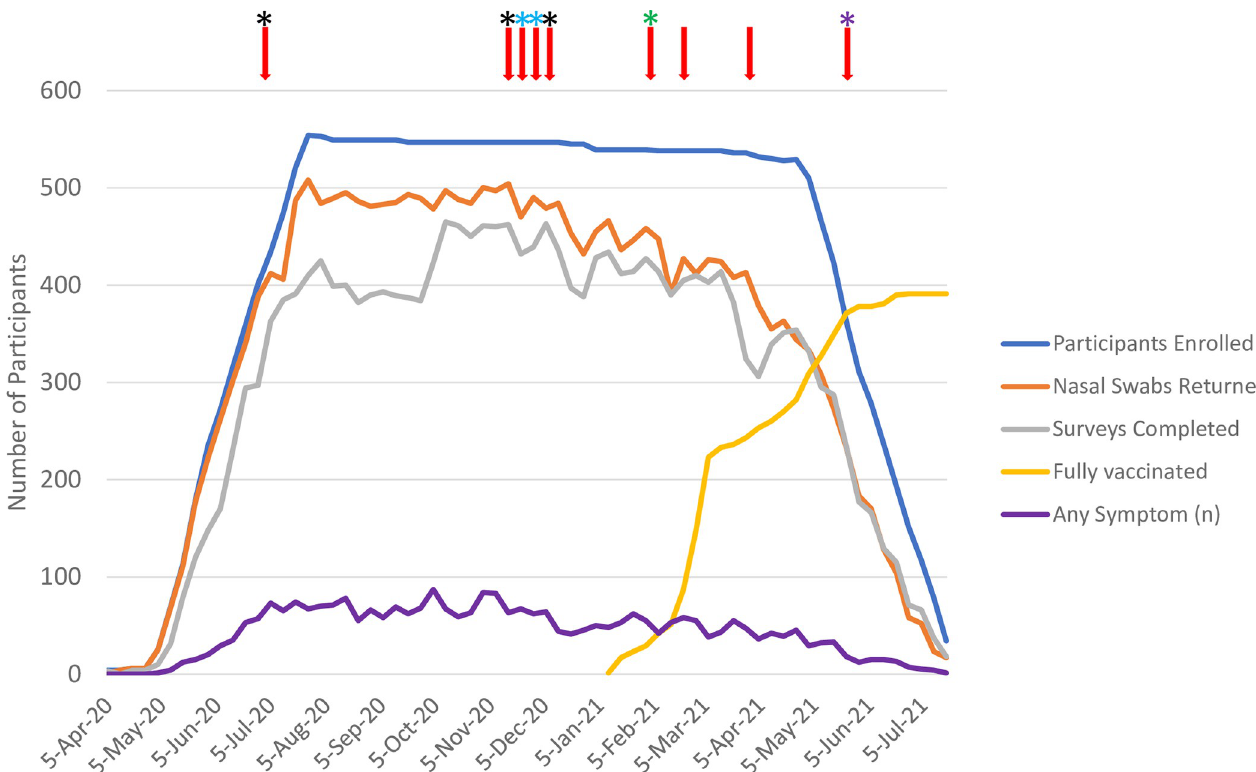
Fig 1. Number of SARS2 rtPCR tests, weekly surveys, and SARS2 cases by calendar week. The study was conducted across a total of 6,411 unvaccinated person weeks, 1,268 partially vaccinated person weeks ( < 14 days from complete vaccination), and 6,845 fully vaccinated weeks ( � 14 days from complete vaccination). SARS2 cases denoted with red arrows. Most cases had a discrete risk factor: black star = health care worker; blue star = family member of SARS2 (+) healthcare worker; green star = household SARS2(+) exposure; purple star = attending in person school. No stars = no identified risk factor.